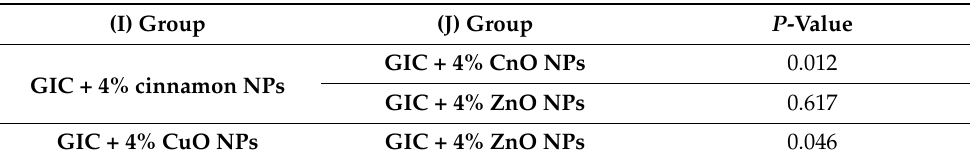
Table 4. The results of the pairwise comparison test on the groups for the addition of 4% cinnamon, 4% CnO, and 4% ZnO NPs into the GIC.